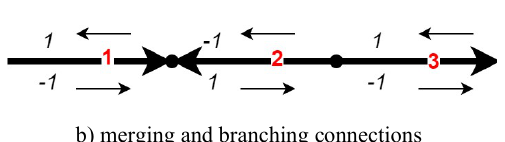
Figure 3. Connection cases of straight road